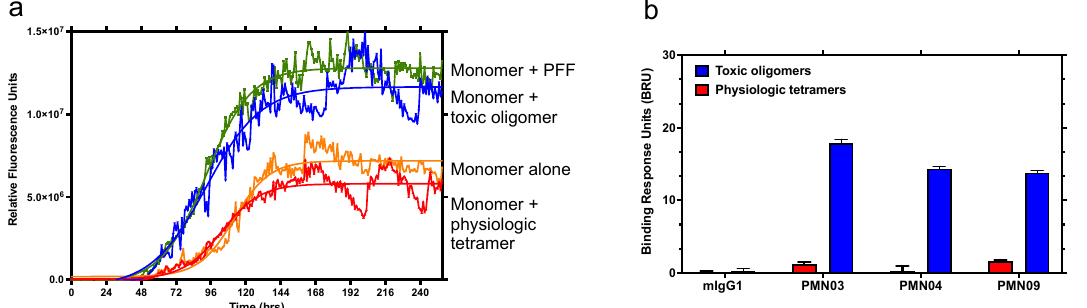
Figure 5. Ability of mAbs to distinguish between toxic oligomers and physiologic tetramers. ( a ) Aggregation was tracked hourly with a ThT fluorescent assay after the addition of α -syn monomers alone (100 mM) or in the presence of PFF (10 nM), toxic oligomers or physiologic tetramers (both 100 nM). Continuous shaking was used to promote aggregation, giving rise to measurable aggregation with monomers alone. Data are representative of 2 independent experiments. ( b ) The binding response of immobilized mAbs and negative control mouse IgG1 (mIgG1) to toxic oligomers and physio- logic tetramers was measured by SPR. The same pattern of binding was observed in 4 independent experiments. Error bars: SEM.